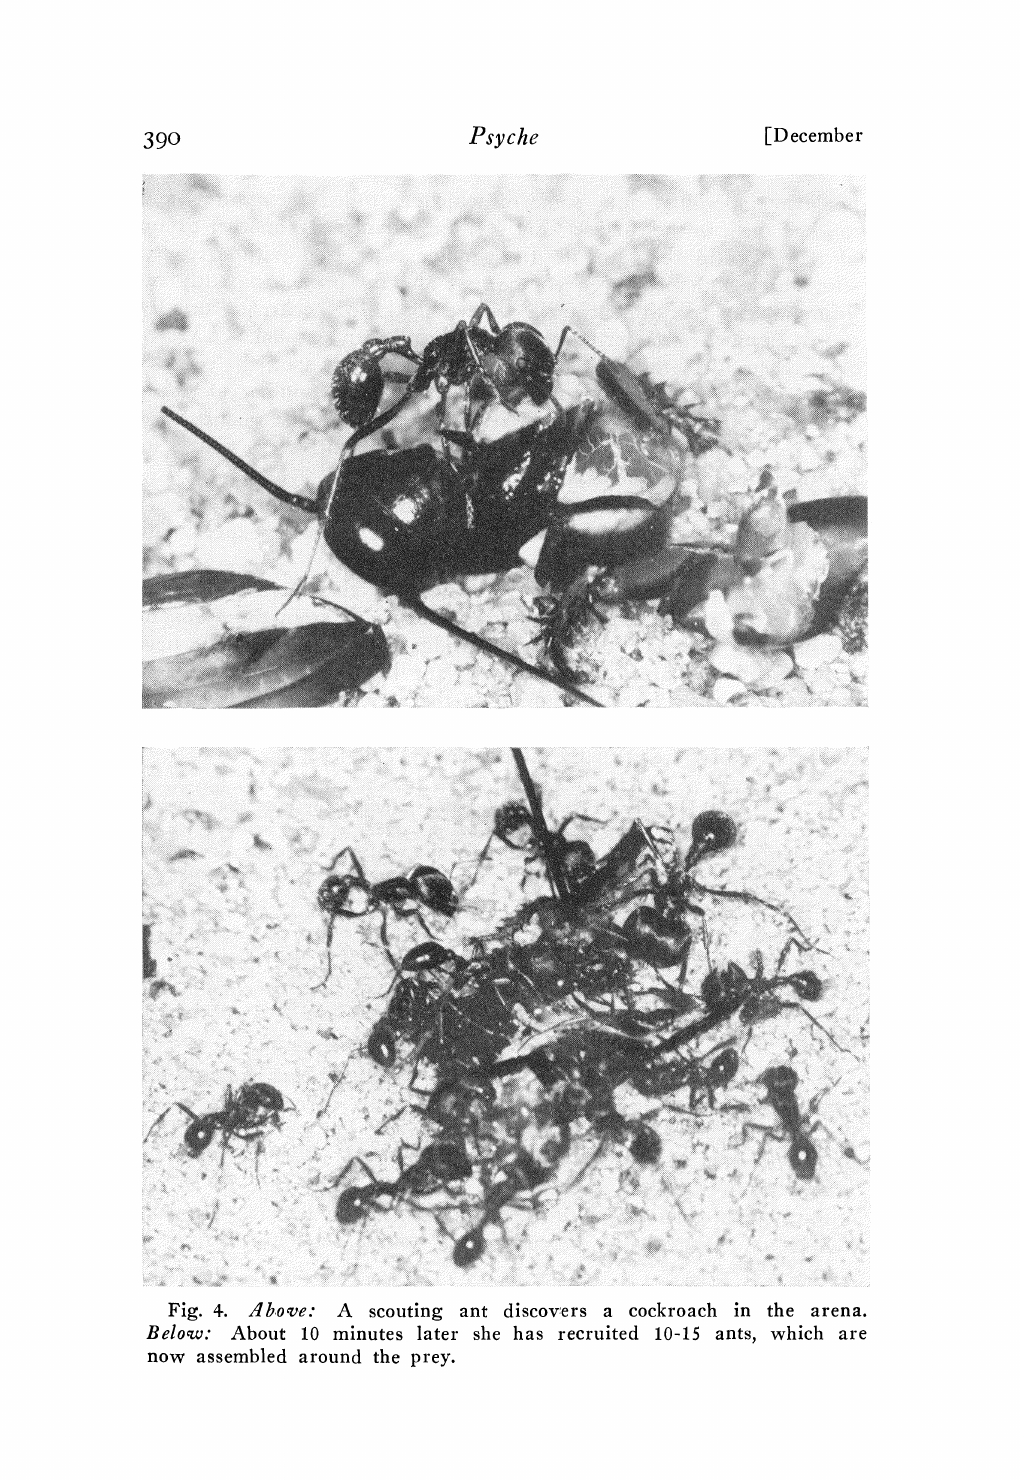
Fig. 4. Ab.oe: A scouting ant discovers a cockroach in the arena. Below: About 10 minutes later she has recruited 10-15 ants, which are now assembled around the